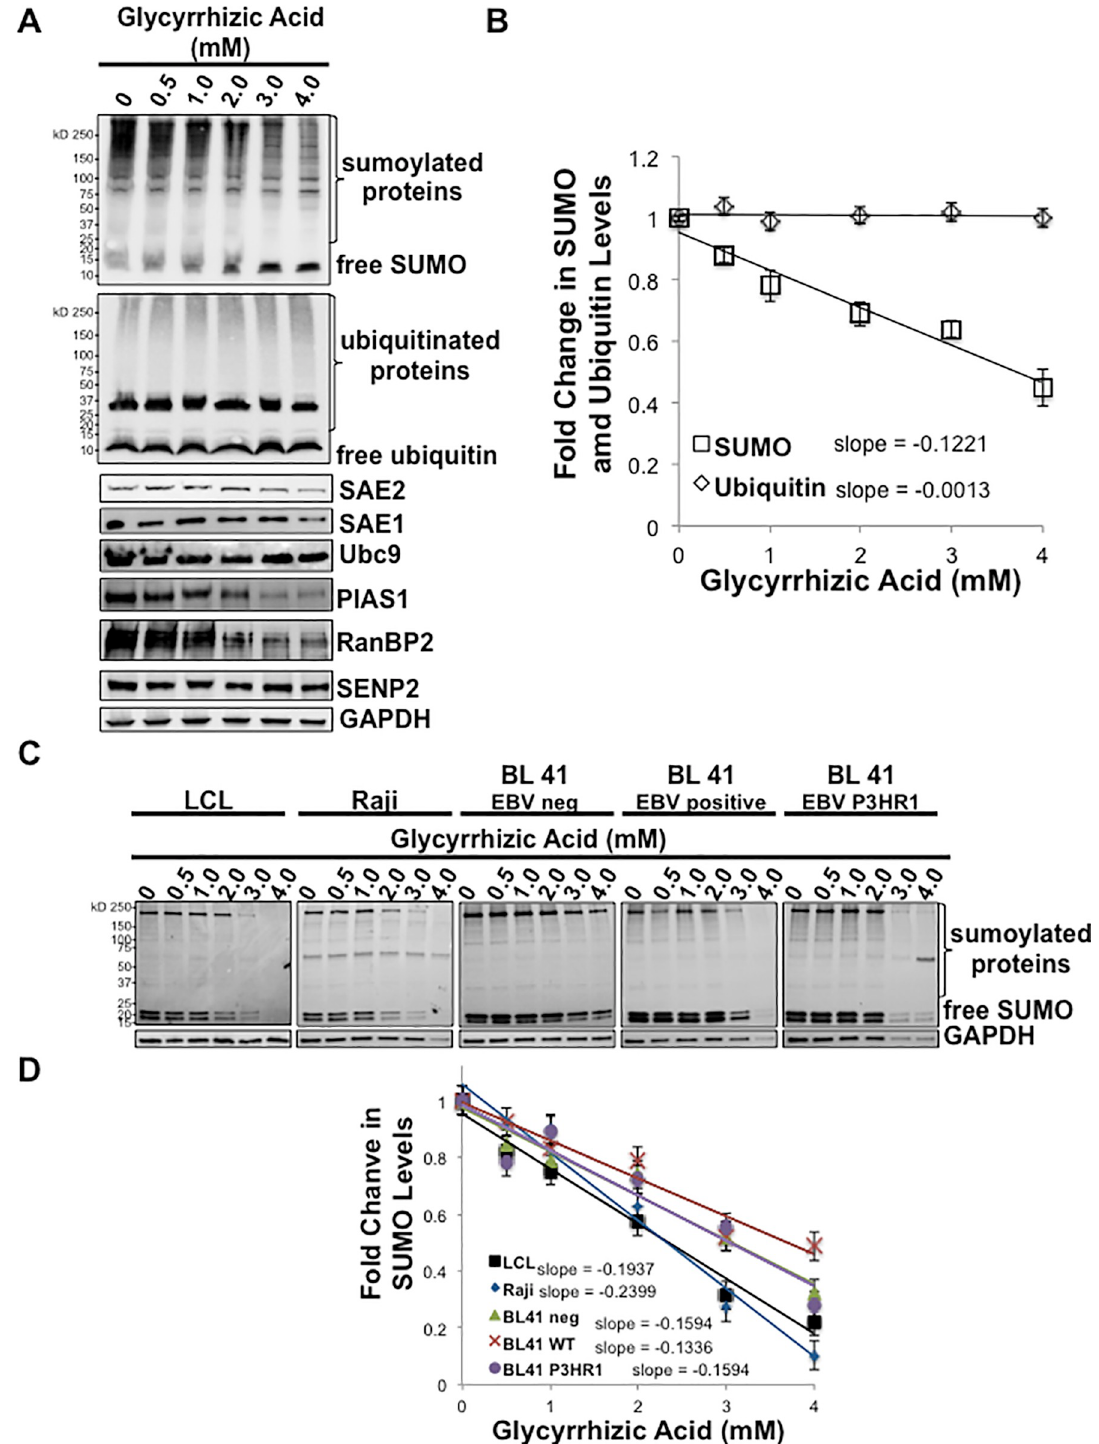
Fig 1. Glycyrrhizic acid decreased levels of sumoylated proteins in a dose-dependent manner. A-B) LMP1-expressing HEK 293 cells were treated with graduated doses of glycyrrhizic acid. 48 hours post-treatment, cells were harvested, lysed, denatured, and A) Western blot analyses performed to detect SUMO-1/2/3, SAE1, SAE2, Ubc9, PIAS1, RanBP2, SENP2, and Ubiquitin levels. GAPDH was used as a loading control. B) Densitometric analysis of repeat experiments was performed to determine relative SUMO and relative Ubiquitin levels. Results are shown as the means ± the standard deviation of experiments performed in triplicate. C) EBV-transformed